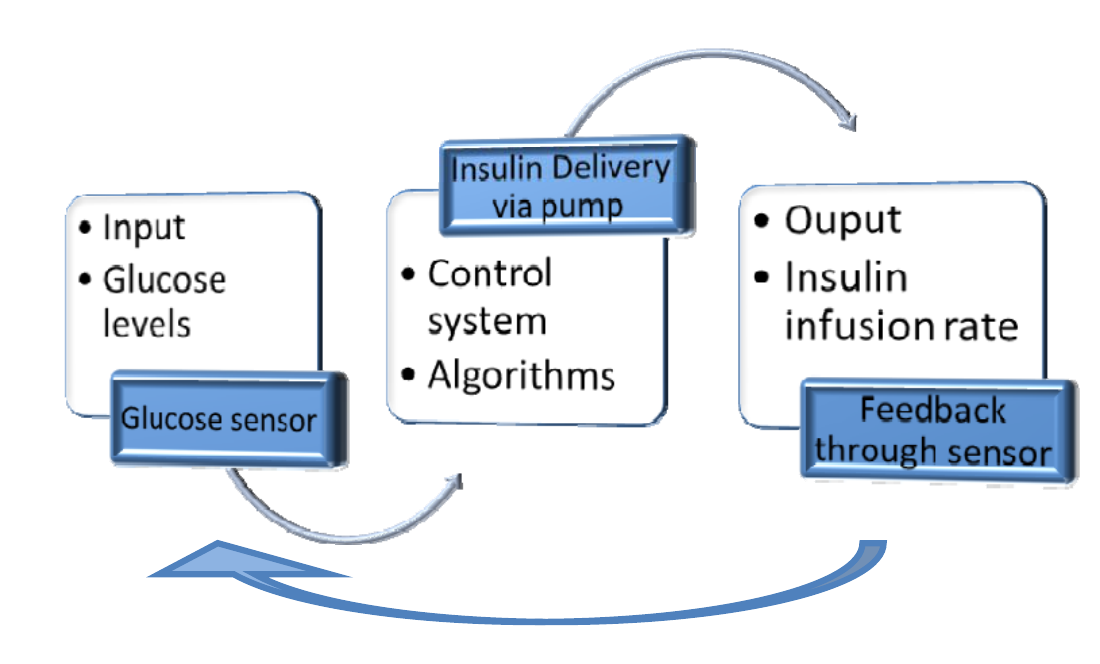
Figure 1. Principles of control systems applied to glycemic